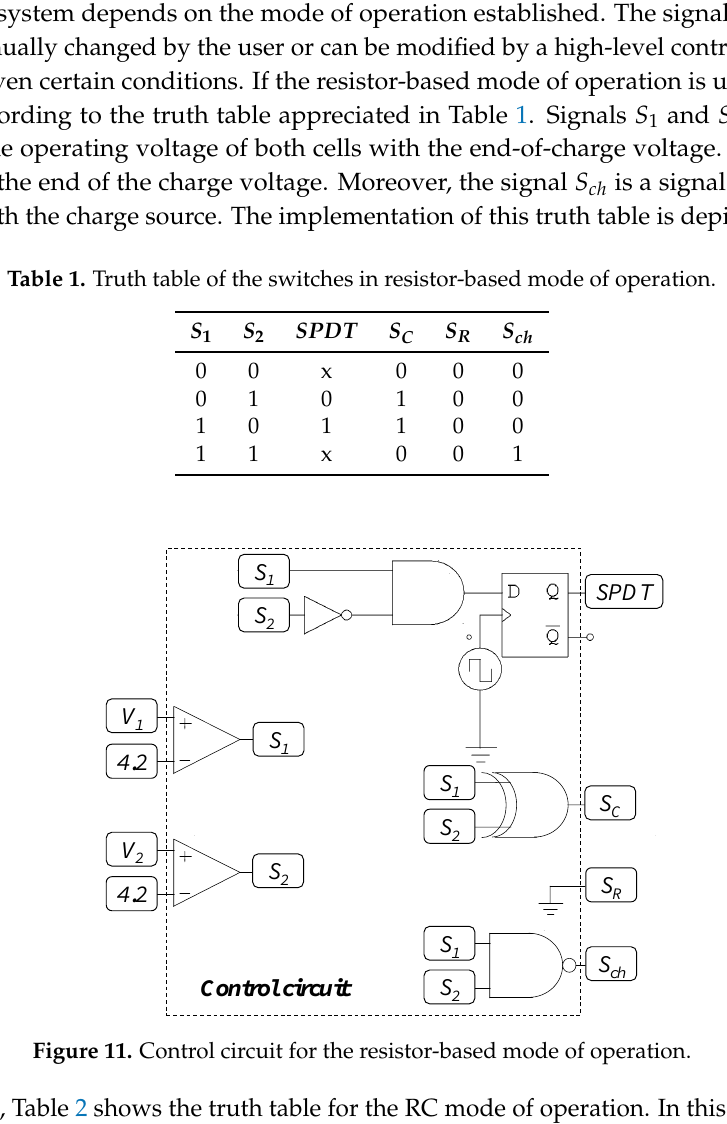
Figure 11. Control circuit for the resistor-based mode of